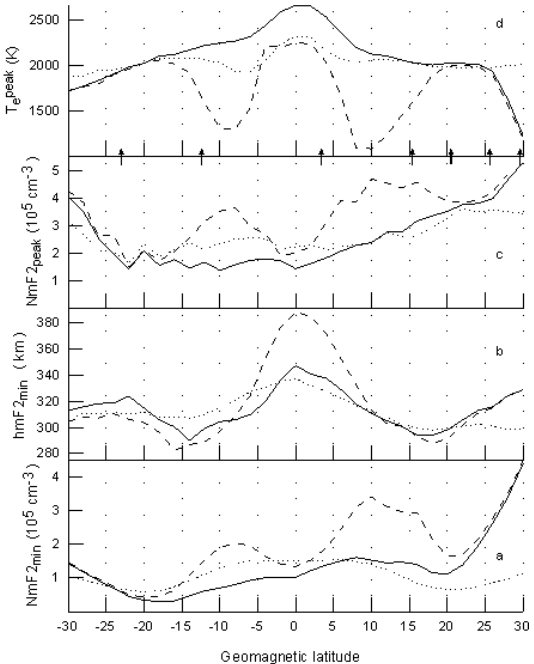
Fig. 18. The calculated minimum nighttime F 2 layer peak electron density (panel (a)), NmF 2 min , and its F 2 peak altitude, hmF 2 min (panel (b)). The dependences of the calculated morning electron temperature peak, T peak e , on the geomagnetic latitude are presented in (panel (d)). The (panel (c)) shows the calculated NmF 2 peak , which is NmF 2 at the point of the morning electron temperature peak calculation. The solid lines show the results given by the model with the corrected equatorial zonal electric field, given by crosses in the bottom and middle panels of Fig. 1, the corrected HWW90 wind, and the corrected NRLMSISE-00 neutral tempera- ture and densities. The dotted lines show the results produced by the model with the same value of the zonal electric field as for the solid lines, zero neutral wind only for the time period after 12:00 UT on 27 August 1987, and the NRLMSISE-00 neutral temperature and densities with the same corrections as for the solid lines. The results shown by dashed lines were calculated by the model with the same corrections of the NRLMSISE-00 neutral temperature and densi- ties and meridional neutral HWW90 wind as for the solid lines, and when the value of the corrected zonal electric field, used in produc- ing results, shown by solid lines, was divided by a factor of 10 at all the studied geomagnetic latitudes only for the time period after 12:00 UT on 27 August 1987. The solid, dotted and dashed lines in the panels (a,b) correspond to 04:40–05:12 SLT on 28 August